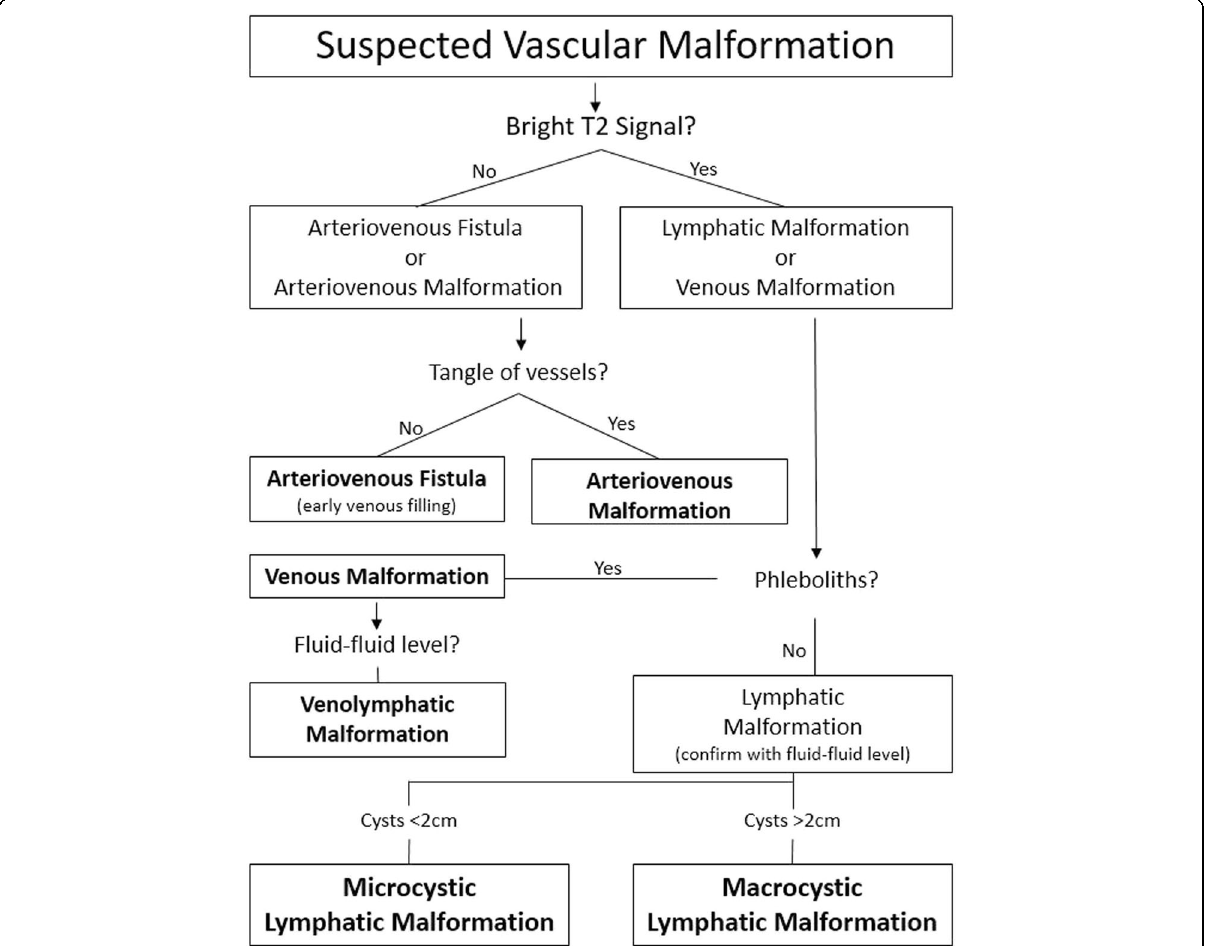
Fig. 7 Imaging-based algorithm for suspected vascular